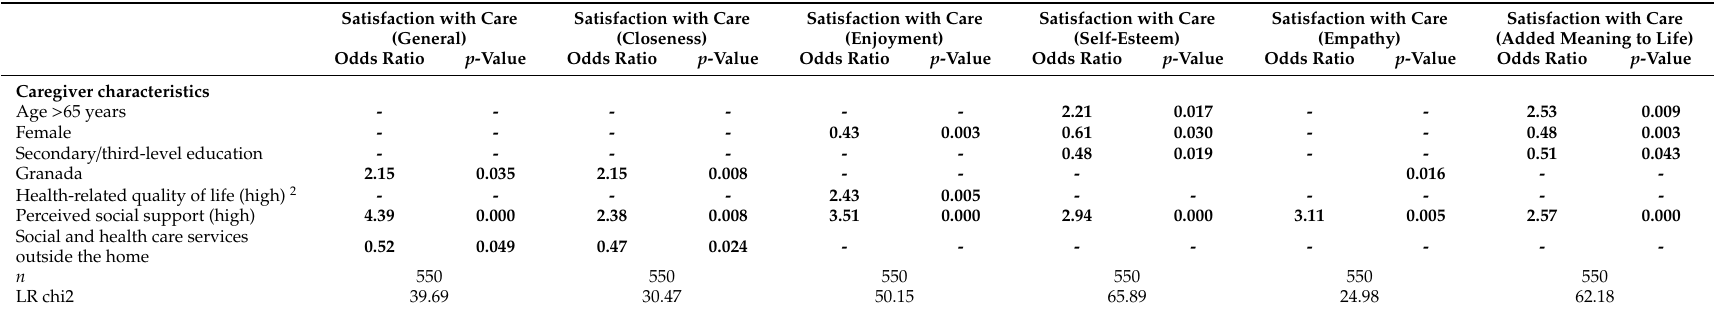
Table 4. Variables associated with informal caregiver satisfaction with caregiving role: multivariate analysis for all caregivers 1 . Satisfaction with Care Satisfaction with Care Satisfaction with Care Satisfaction with Care Satisfaction with Care Satisfaction with Care (General) (Closeness) (Enjoyment) (Self-Esteem) (Empathy) (Added Meaning to Life) Odds Ratio p -Value p -Value